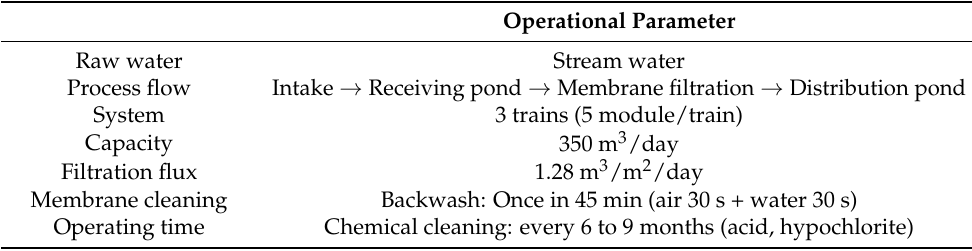
Table 1. Overview of the membrane filtration plant.